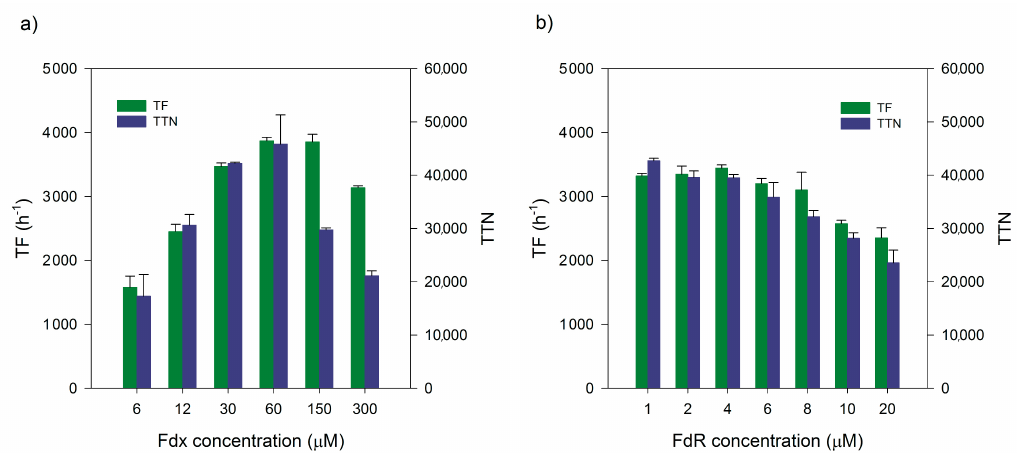
Figure 3. Effect of ferredoxin (Fdx) and ferredoxin reductase (FdR) concentration on initial reaction rates (TF) and stability (TTN). Reaction conditions: 1 mL aqueous reaction mixture containing 1 µ M CYP153A6, 1 ( a ) or 1–20 µ M FdR ( b ), 6–300 ( a ) or 30 ( b ) µ M Fdx, 10 mg mL − 1 BSA, 0.5 U mL − 1 catalase, 0.1 mM NADH, 0.1 U mL − 1 GDH, 200 mM glucose, 50% ( v / v ) CFE from 200 g (wet weight) L − 1 cell suspension, buffer: 200 mM Tris-HCl (pH 8) with 250 µ L n -octane added, 20 ◦ C, 200 rpm, t = 3 h for TF, t = 28 h for